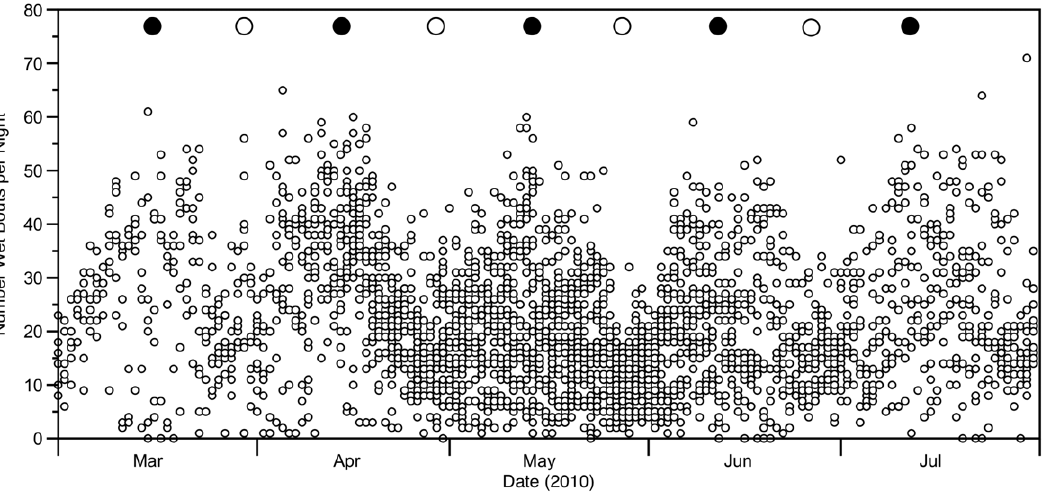
Figure 3. Number of landings on the surface of the water at night for 37 swallow-tailed gulls ( Creagrusfurcatus ) during the breeding period on Espan˜ola Island. Filled and unfilled symbols at top represent new and full moons, respectively.